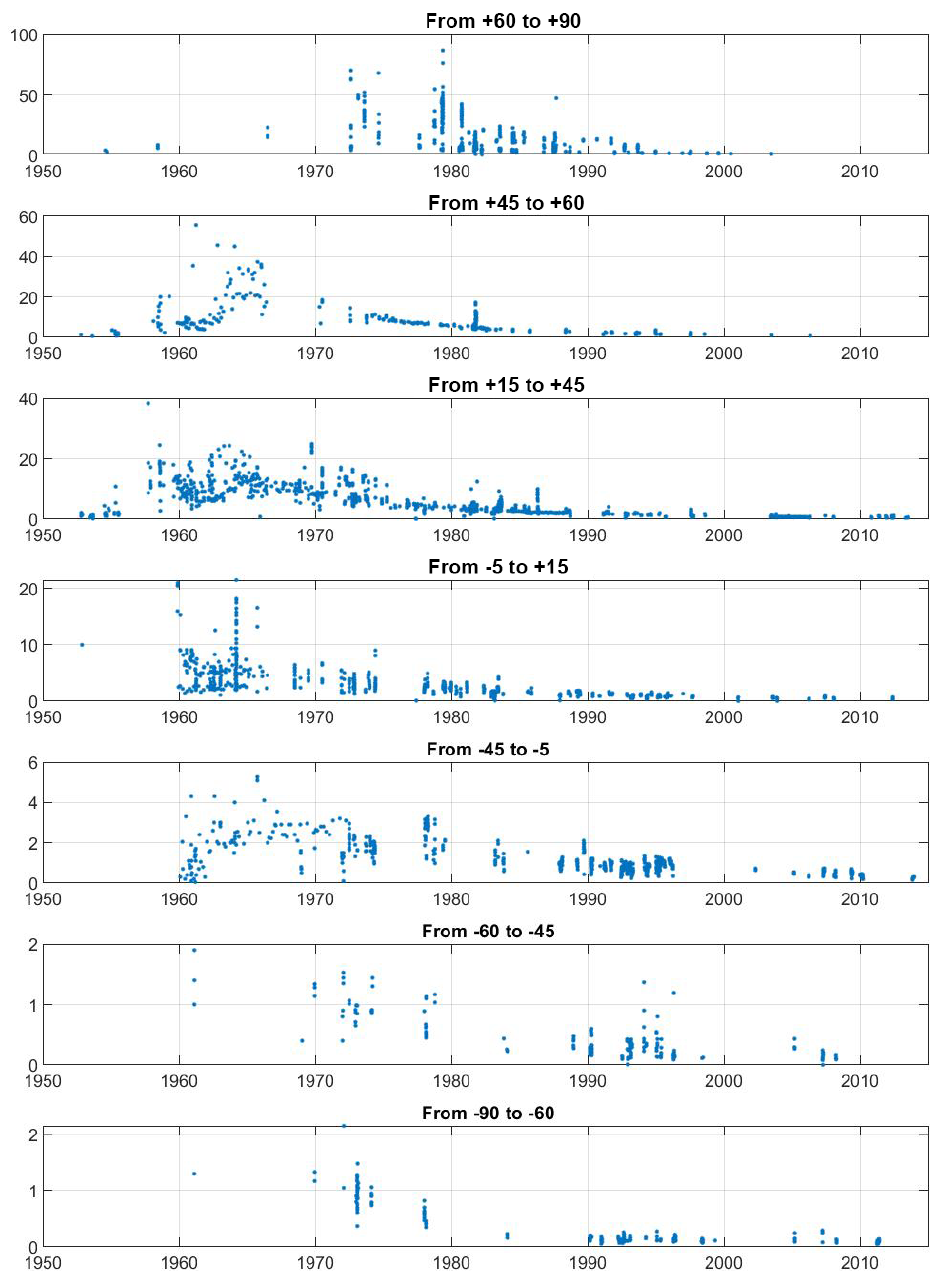
Figure 4. Global ocean surface water (depth < 50m) tritium concentrations (in TU) for selected latitude bands.